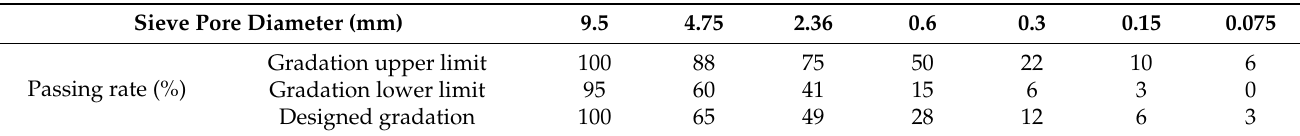
Figure 2. Gradation curves of mixtures. Table 1. Aggregate Grading.